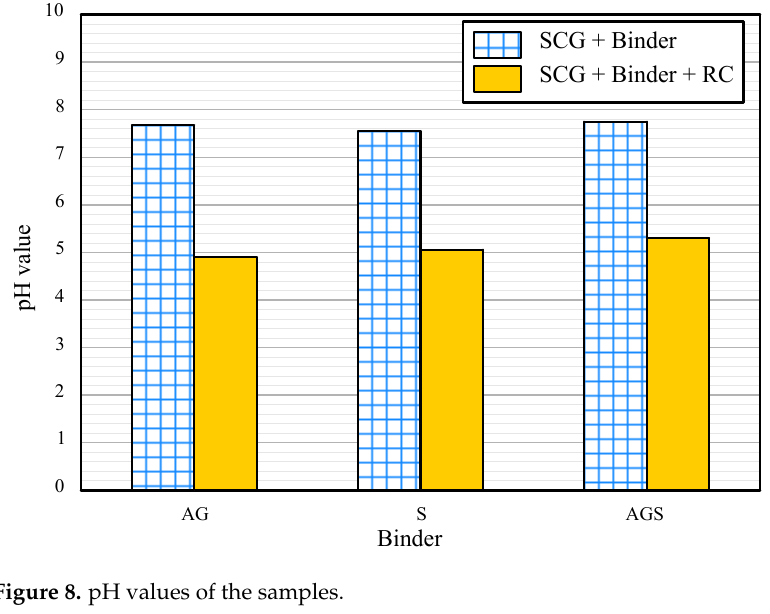
Figure 8. pH values of the samples.